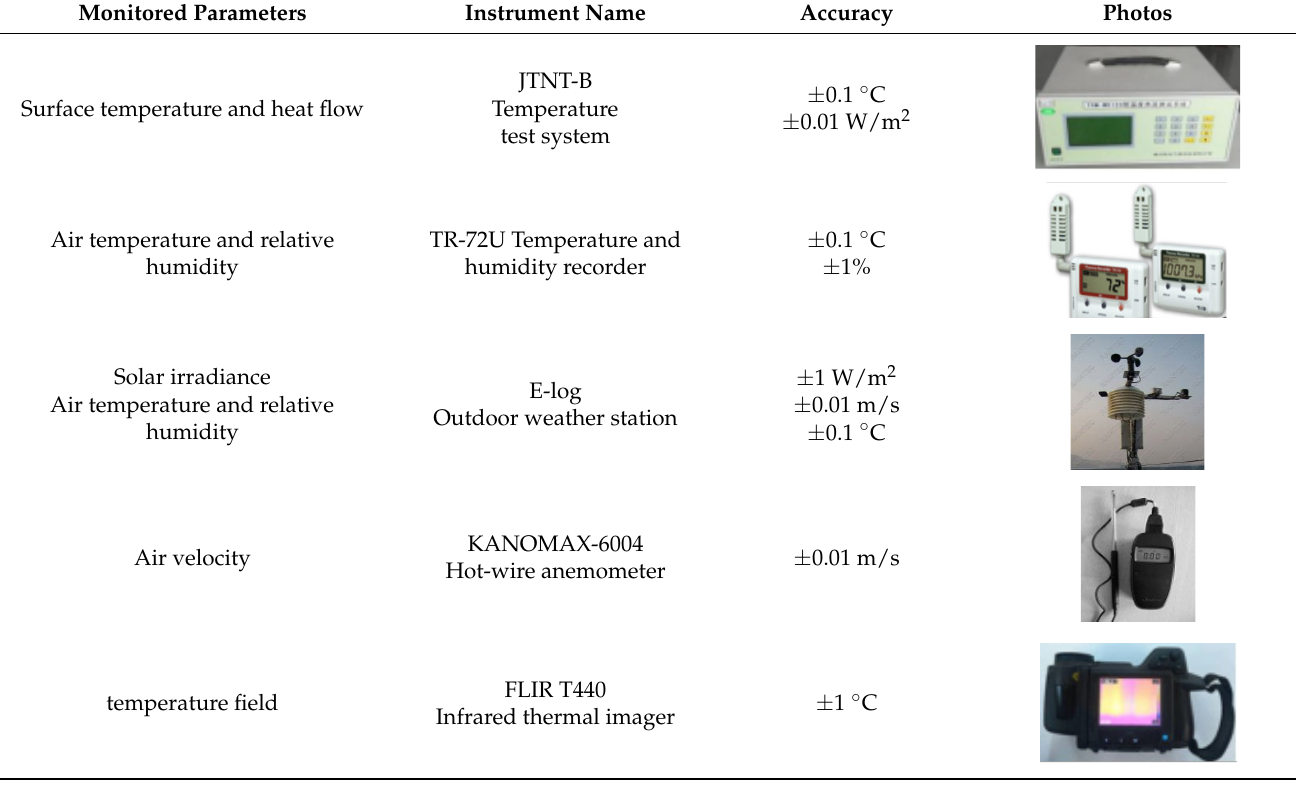
Table 5. Monitored data and technical specification of measuring instruments.